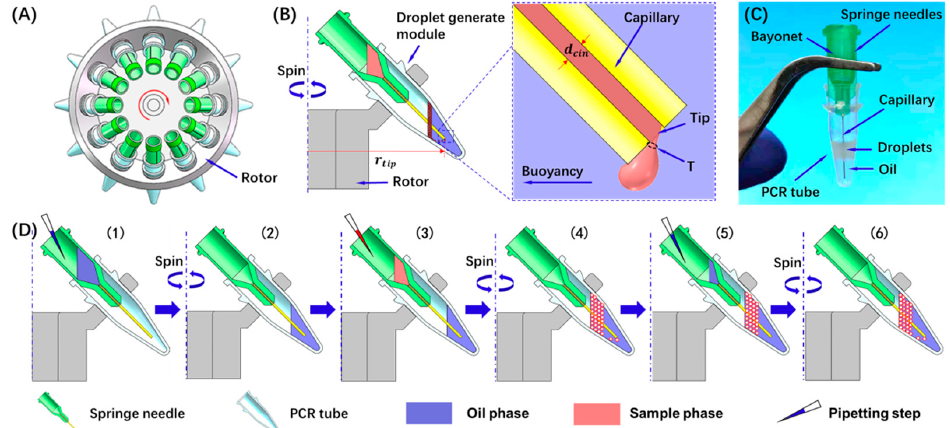
Figure 1. System description and workflow of the CBbE method. ( A ) Droplet generation using a benchtop centrifuge, needle, and PCR tube. ( B ) Working principle of the CBbE method. When the sample is transferred through the capillary and flows out of the tip, the buoyancy force causes the extruded sample to break off into a droplet. ( C ) Needle and PCR tube with droplets generated by the CBbE method. ( D ) Workflow of the CBbE emulsification with zero dead volume. Step 1: Add oil to the needle. Step 2: Spinning forces oil to flow through the capillary and into the PCR tube, causing the tip of the capillary to become hydrophobic. Step 3: Aqueous sample is added to the needle. Step 4: The sample is emulsified during centrifugation, while some sample remains in the capillary. Step 5: Add oil into the needle again. Step 6: Spinning forces more oil into the capillary, which pushes the remaining sample out to form more droplets.